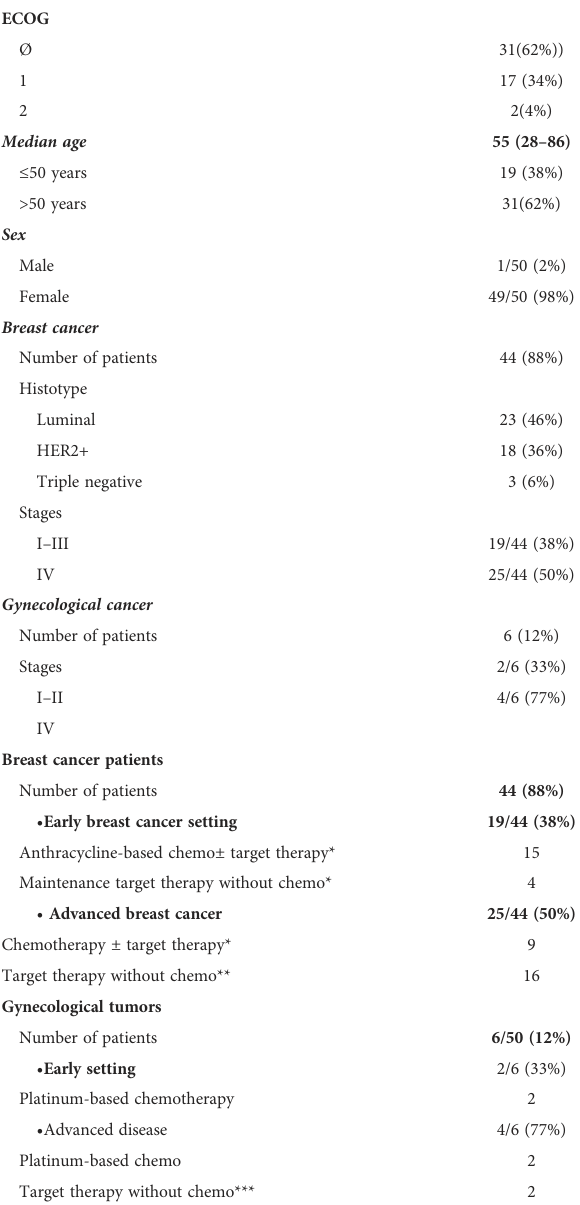
TABLE 1 Patients ’